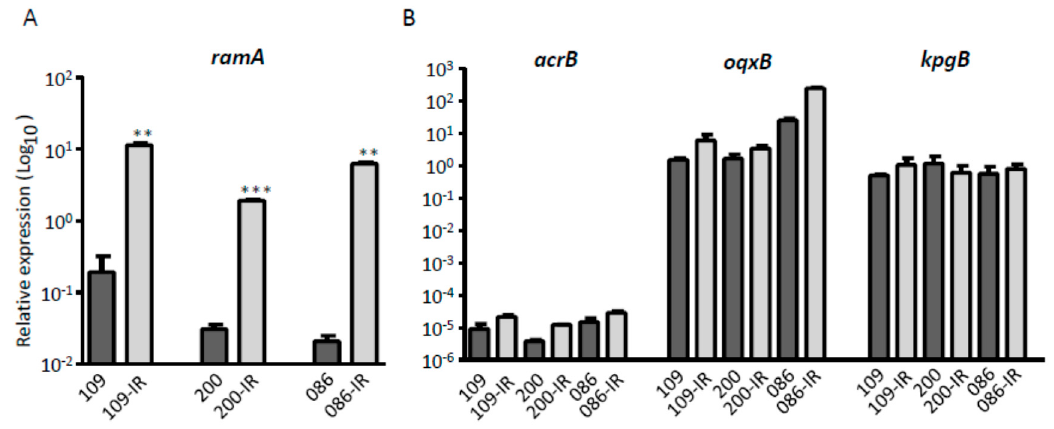
Figure 6. Expression levels of genes related to tigecycline resistance. ( A ) The expression level of the transcriptional activator gene ramA . ( B ) The expression levels of three efflux pump genes, acrB , oqxB , and kpgB . The fold-changes were calculated using the comparative threshold cycle ( ∆∆ C T ) method. **, p < 0.001; ***, p < 0.0001.